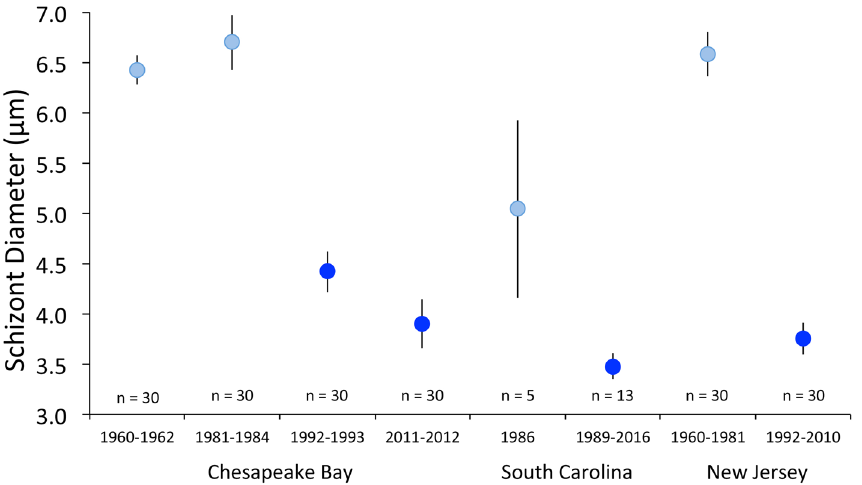
Figure 2. Perkinsus marinus schizont diameters (microns) before (light blue) and after (darker blue) the emergence of the contemporary P. marinus phenotype, in Chesapeake Bay, South Carolina and New Jersey. Note that for South Carolina the 1986 data represent trophozoites, as schizonts could not be definitively identified in the tissue sections. Filled circles represent means with 95% confidence intervals. Reductions in cell diameters with emergence of the contemporary phenotype within each area were statistically significant, as noted in the text. For Chesapeake Bay, Tukey multiple comparisons revealed significant cell size reductions between 1981–1984 and 1992–1993 ( P = 0.0000000) and between 1992–1993 and 2011–2012 ( P = 0.0050495), but not between 1960–1962 and 1981–1984 ( P =